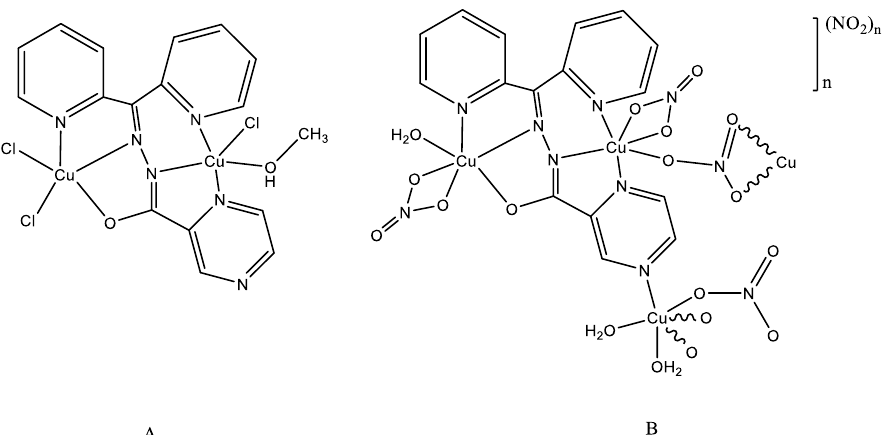
Figure 7. Structure of the copper(II) complexes derived from aroylhydrazone N ’ -(di(pyridin-2- yl)methylene)pyrazine-2-carbohydrazide; ( A ) Complex [Cu 2 (μ - 1κN 3 ,2κN 2 O-L)(Cl) 3 (MeOH)] ( B )